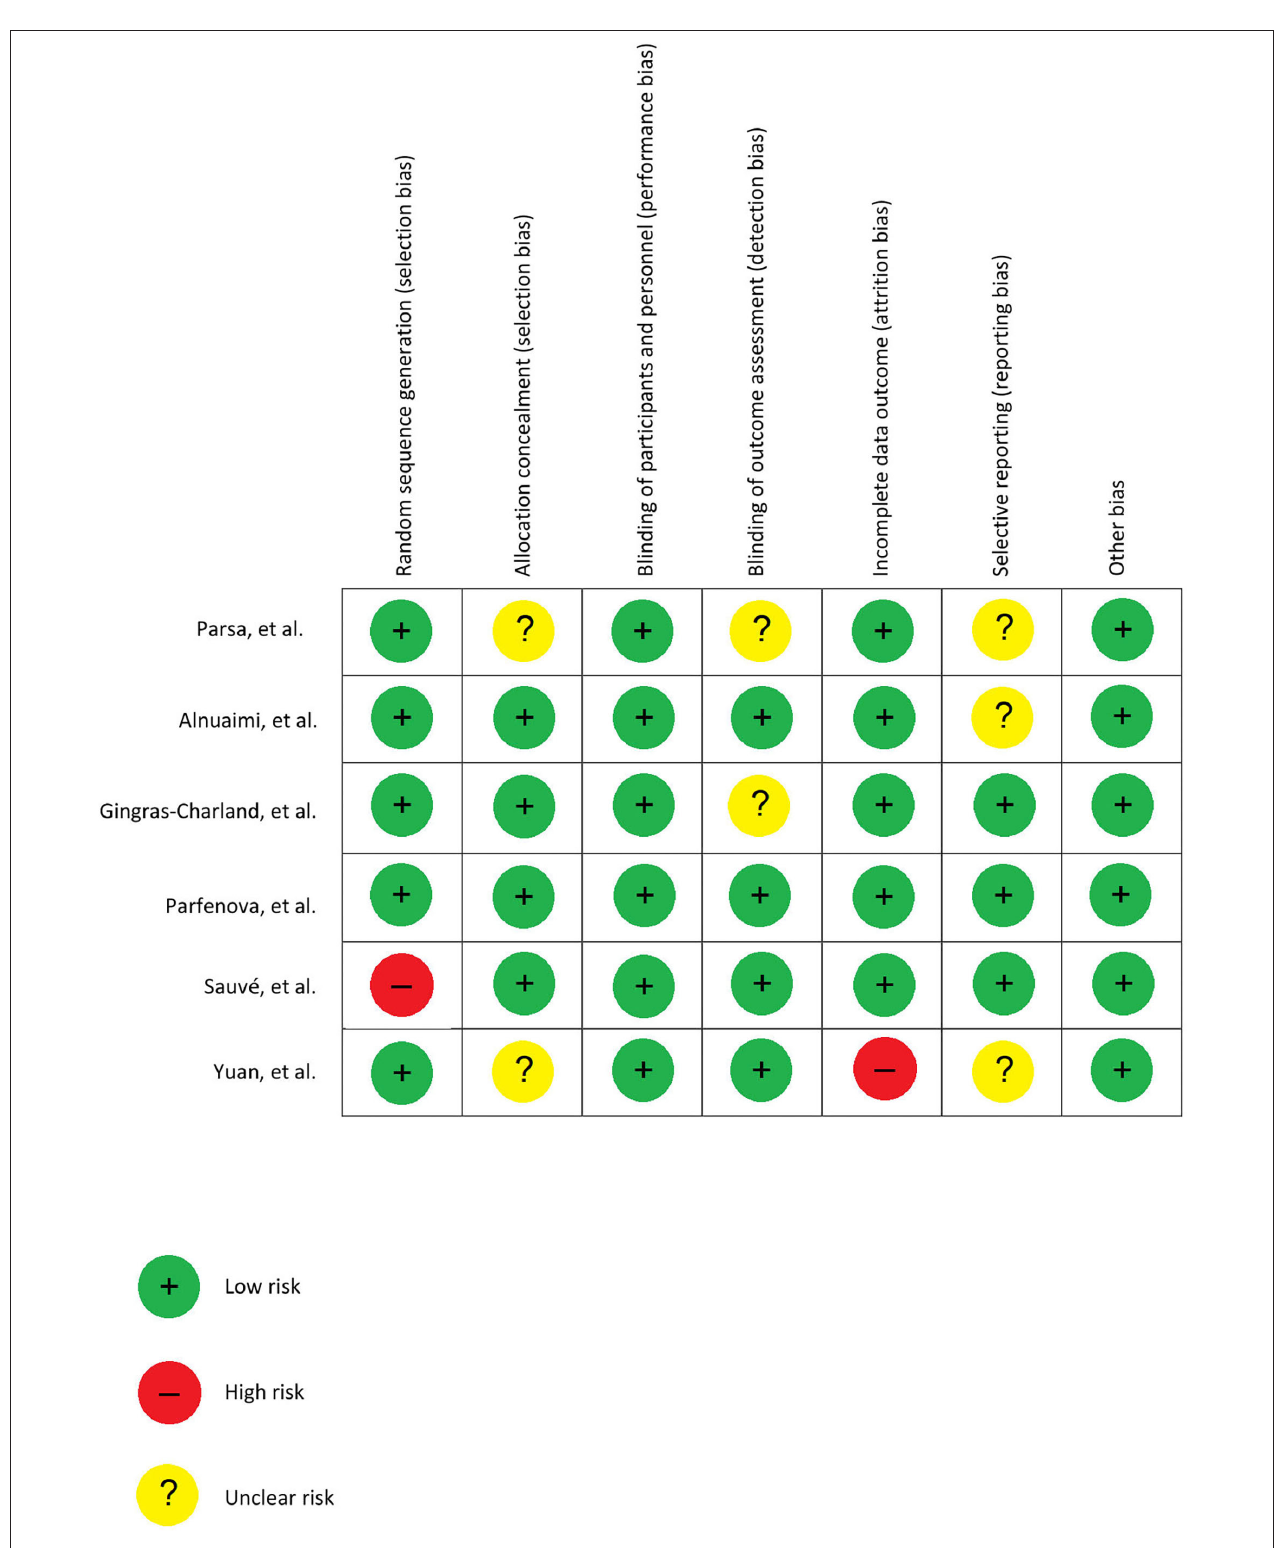
FIGURE 2 | Risk of bias of the included